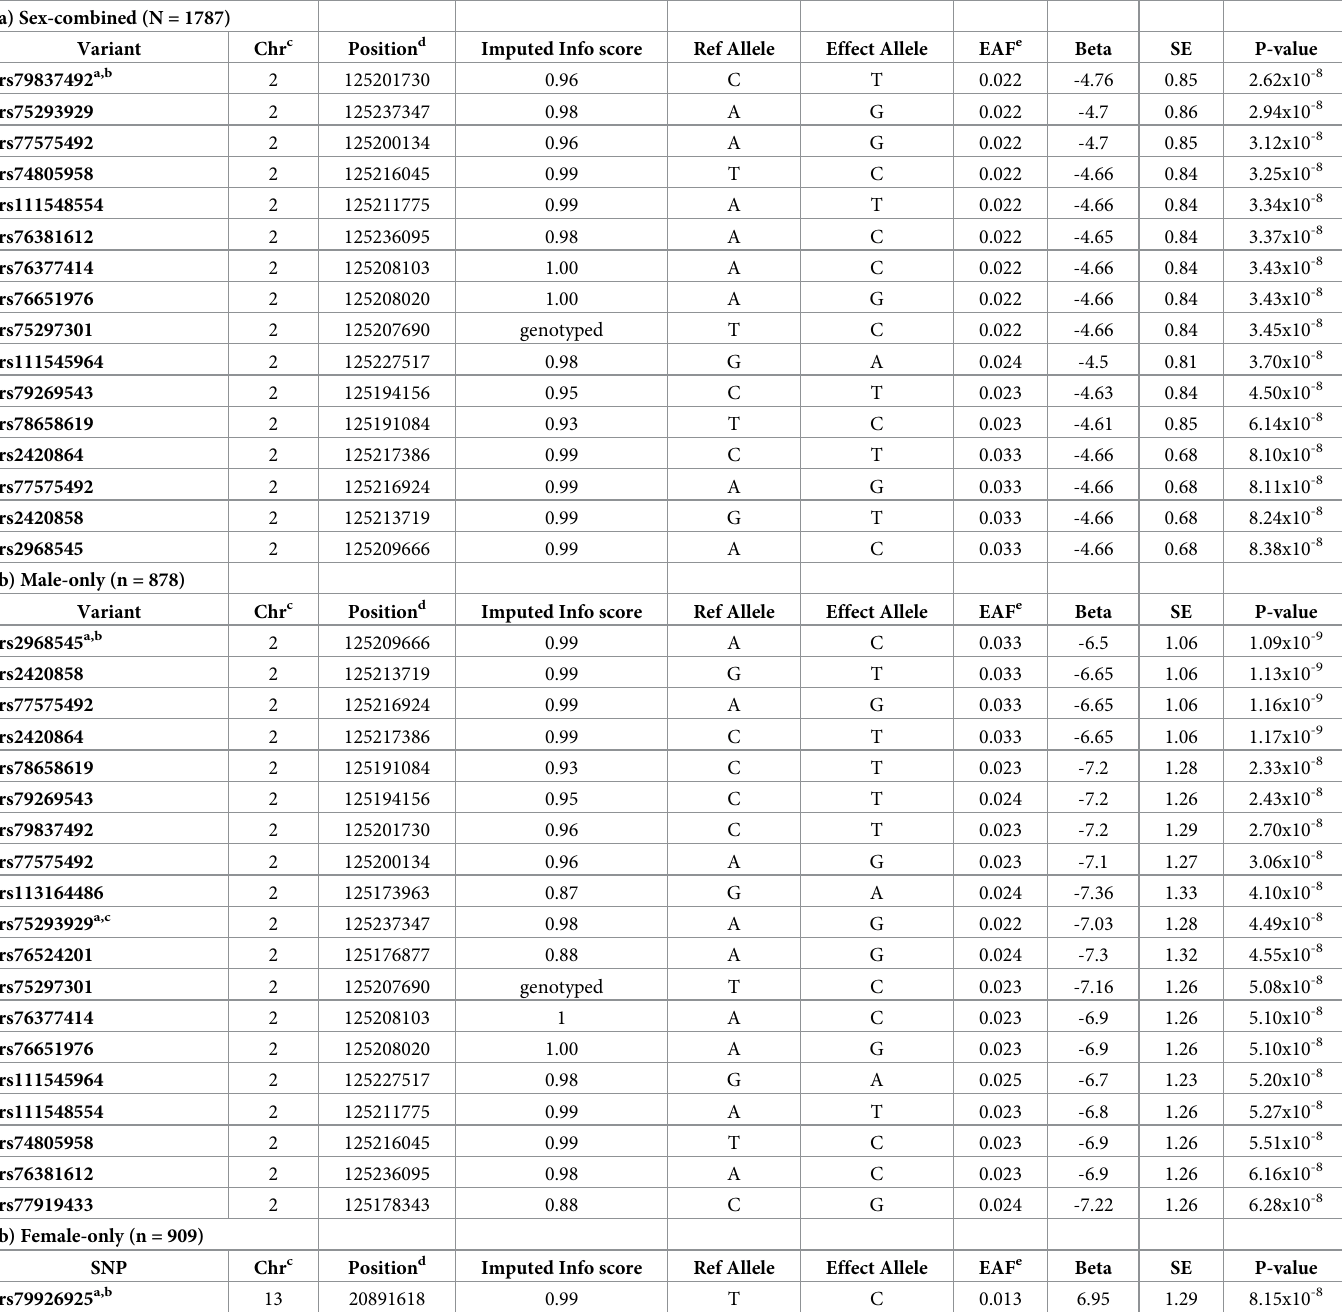
Table 2. Genetic variants associated with the ratio of visceral fat to abdominal area in the MEC-APS (P < 10 − 7 ). a) Sex-combined (N =